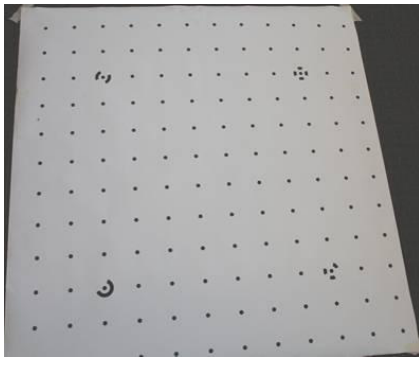
Figure 2. Calibration template used by PhotoModeler software Camera self-calibration trials - iPhone 4G camera Twelve photos captured from the iPhone 4G were used for the calibration process. The results are listed in table 2.